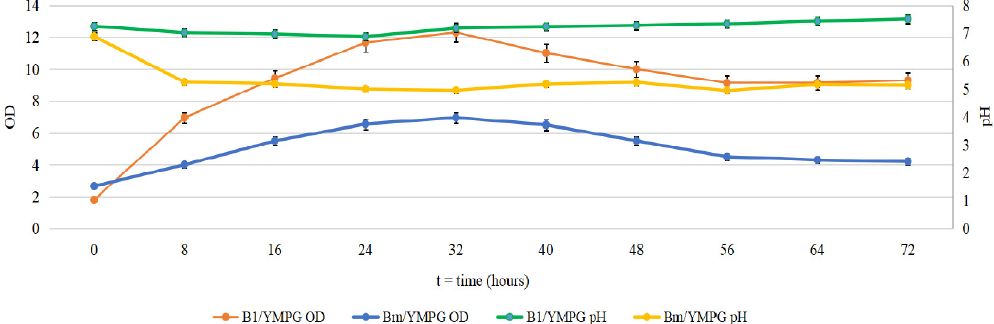
Figure 5. Growth of P. putida (B1) and B. mycoides (Bm) strains in YMPG medium.